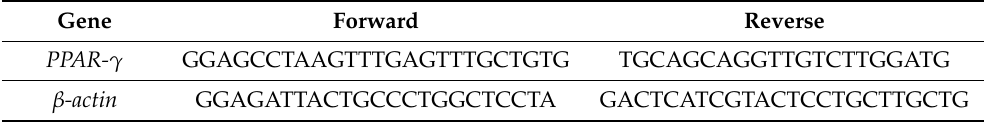
Table 1. The sequence of primer pairs for